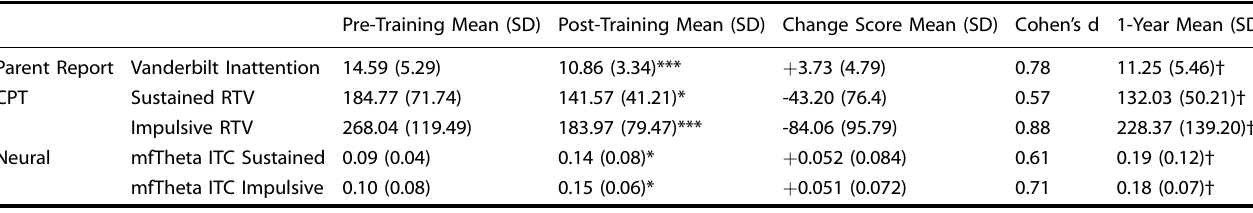
Fig. 3 Parent report of inattention and CPT task over time. a Parent report of inattention (Vanderbilt) over time illustrating the group mean at each time point. b Scatterplot illustrating trending correlation between the change on the Vanderbilt inattention measures versus overall change in accuracy collapsed across BBT training modules ( r = 0.42, p = 0.05). c CPT (sustained condition) response time variability over time illustrating the group mean at each time point. d CPT (impulsive condition) response time variability over time illustrating the group mean at each time point. * p < 0.05. Error bars represent s.e.m. Table 1. Primary outcome